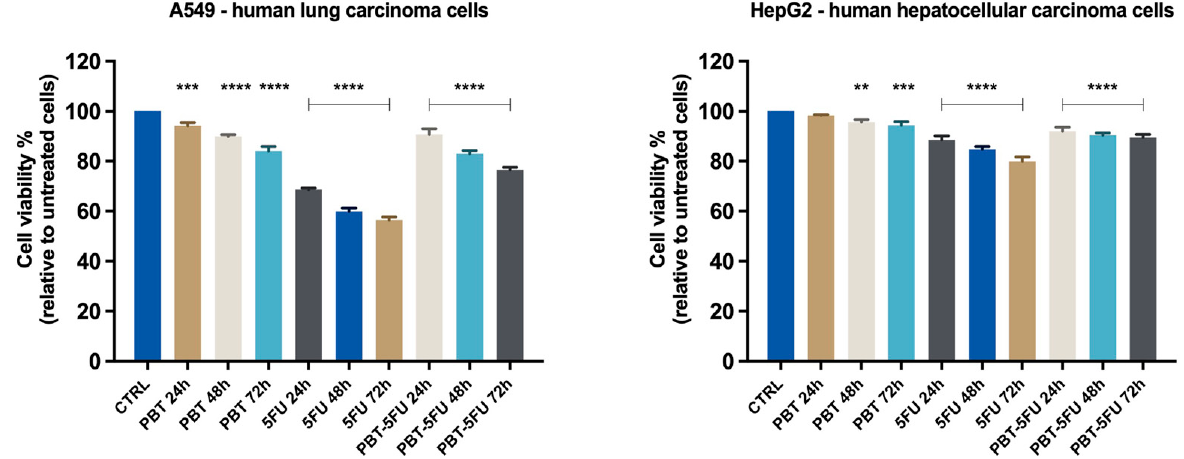
Figure 2. In vitro evaluation of the effect exerted by PBT ( Lactobacillus sporogenes : Clostridium butyricum TO-A = 25:1, 10 7 million CFU), 5FU (5-fluorouracil 25 µM), and PBT-5FU after 24, 48, and 72 h of treatment on A549 and HepG2 cells’ viability by performing the MTT assay. Data are presented as viability percentages (%) normalized to a control (untreated cells) and expressed as mean values ± SD of three independent experiments performed in triplicate. The statistical differences between untreated and the treated cells were analyzed by applying the one-way ANOVA method followed by Dunnett’s multiple comparisons post-test (** p < 0.01; *** p < 0.001 **** and p < 0.0001).